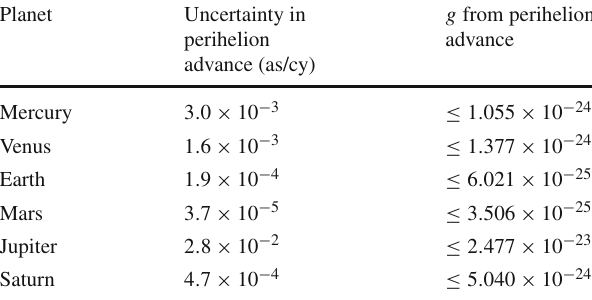
Table 2 Summary of the uncertainties in the perihelion advance in arc- seconds per century and upper bounds on gauge boson-electron cou- pling g for the values of M Z (cid:2) discussed in Table1 for planets in our Solar System g from perihelion Planet Uncertainty in perihelion advance